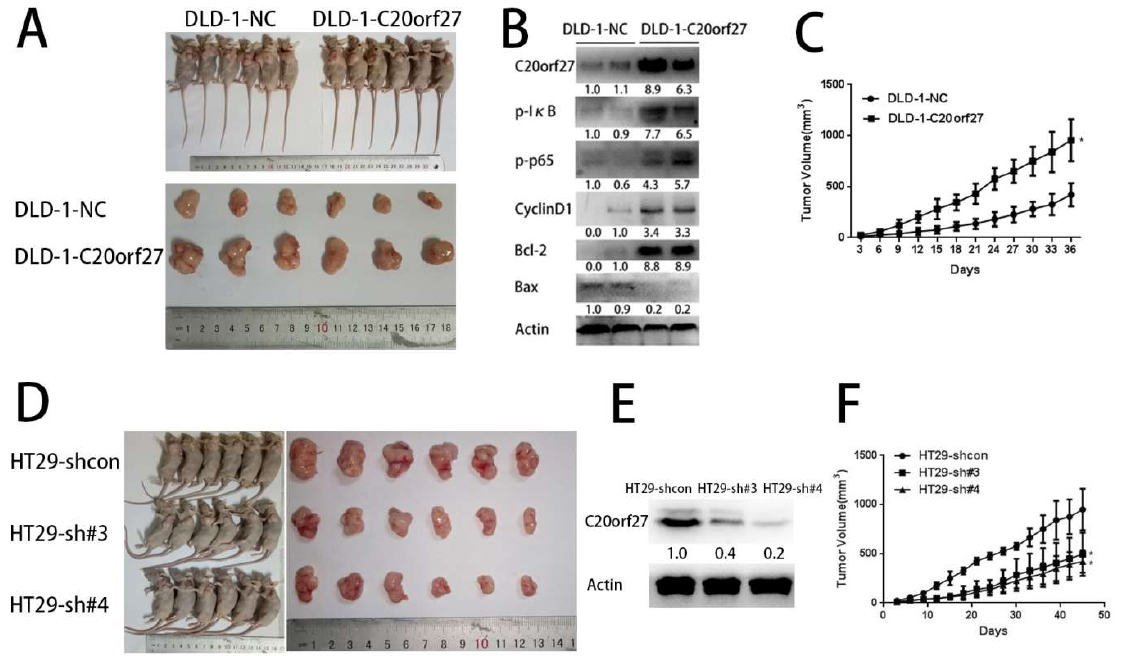
Figure 6. C20orf27 promotes tumor growth and proliferation in vivo. ( A ) Formation of tumors in mice injected with C20orf27 overexpression and control cells; ( B ) Western blot analysis in tumor tissues; ( C ) Tumor volume of nude mice with C20orf27 overexpression and control cells during the experiment; ( D ) Formation of tumors in mice injected with C20orf27 silencing and control cells; ( E ) Western blot analysis in tumor tissues; ( F ) Tumor volume of nude mice with C20orf27 silencing and control cells during the experiment. * p < 0.05.